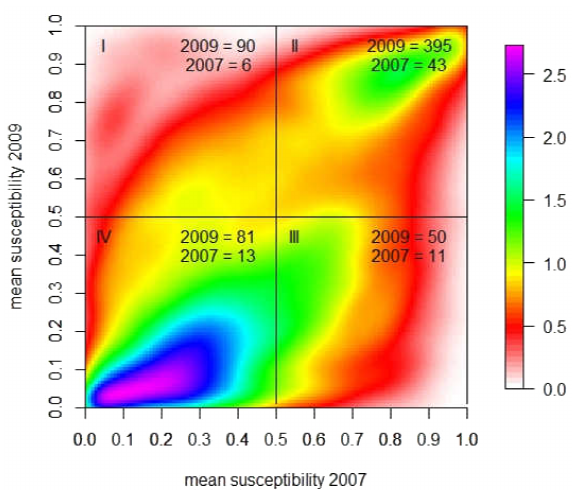
Figure 15. Dispersion density plot calculated using a 2-D binned kernel density algorithm (range for density calculation 0.045xy). Positive cases for 0.5 cut-off values are reported for the two inven- tory